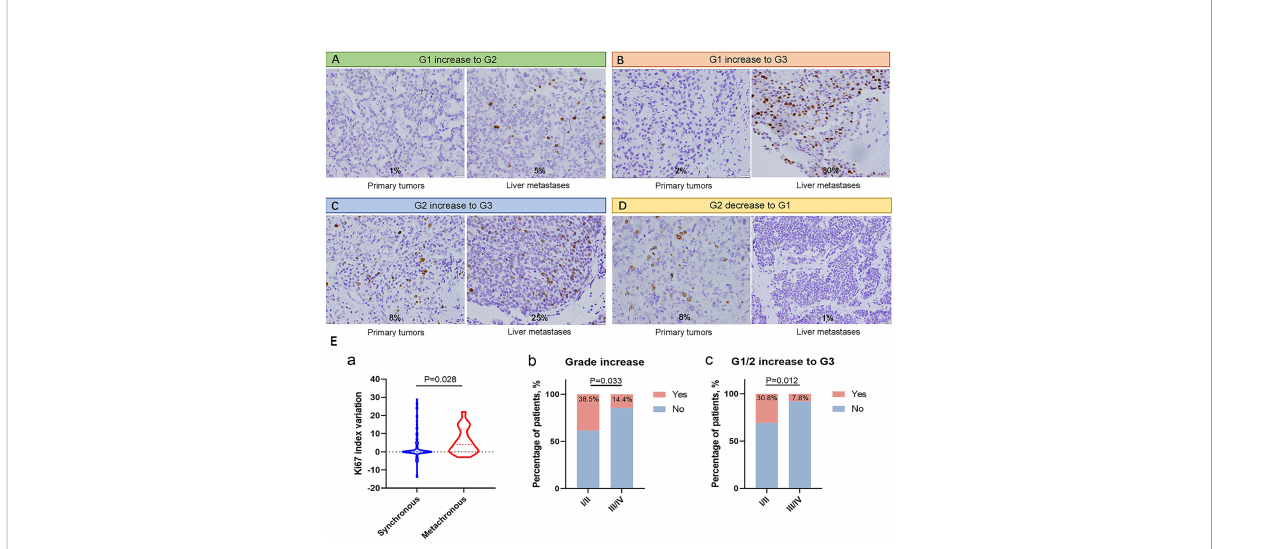
FIGURE 2 (A – D) Immunohistochemistry staining of Ki67 in available paired primary tumors and metastases, showing G1 increase to G2, G1 increase to G3, G2 increase to G3, and G2 decrease to G1, respectively. Magni fi cation: 400×. (E) Association among clinicopathological characteristics,